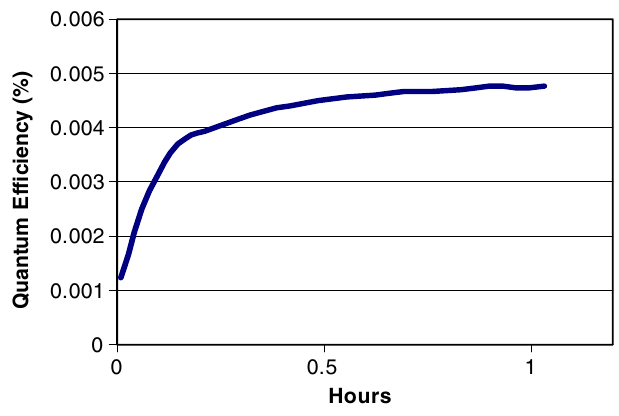
FIG. 1. (Color) Plot of the Q.E. (%) as a function of time for an uncoated Cu target illuminated at 4 : 8 W = cm 2 with 257 nm laser light. The initial increase in quantum efficiency is due to surface cleaning by the UV irradiation. The 257 nm UV line decomposes ozone and produces high energy O (cid:5) (activated oxygen). In addition, the 257 nm radiation is absorbed by most hydrocarbons [16].